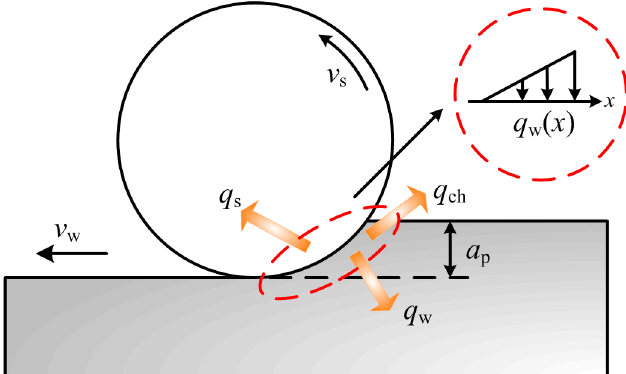
Figure 1. Grinding heat source and boundary conditions.